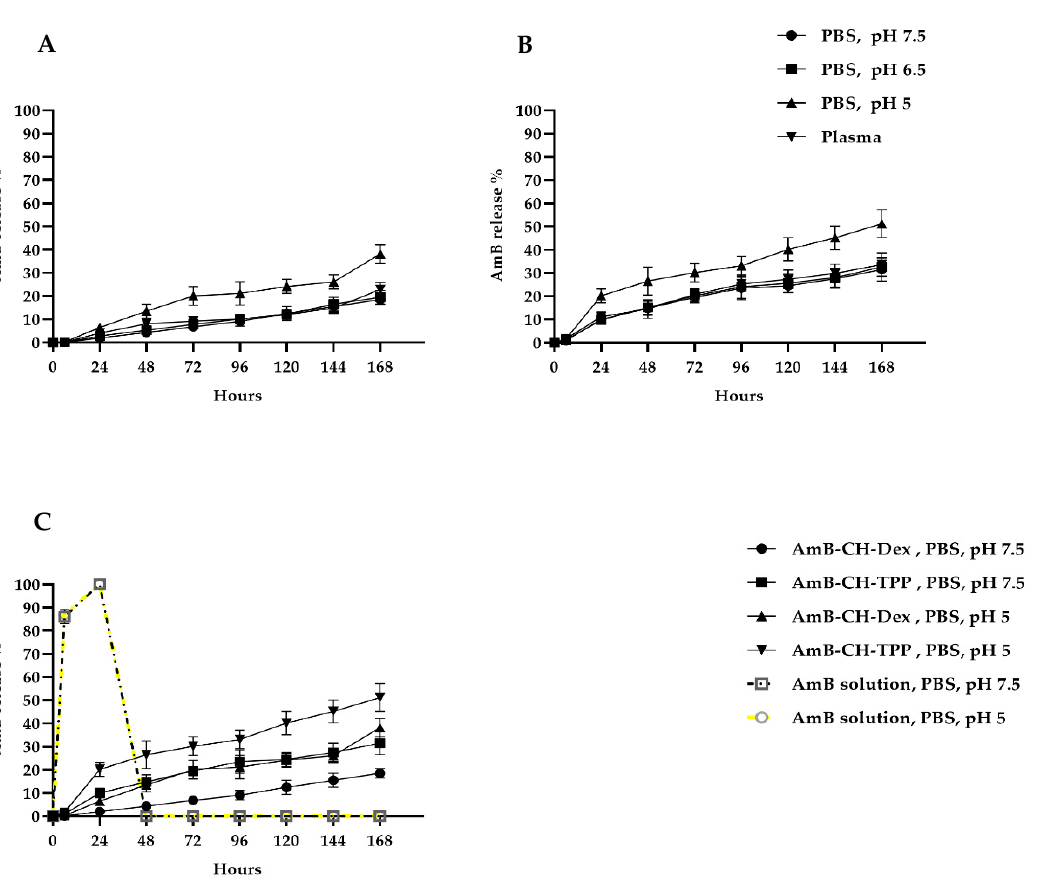
Figure 1. In vitro release profiles of AmB from chitosan nanoparticles at 37 ◦ C. ( A ) AmB-CH-Dex in PBS (pH of 5, 6.5 or 7.5) and mouse (BALB / c) plasma, ( B ) AmB-CH-TPP in PBS (pH of 5, 6.5 or 7.5) and mouse (BALB / c) plasma. ( C ) A comparison of AmB release from AmB solution, AmB-CH-TPP and AmB-CH-Dex nanoparticles in PBS at pH 5 and 7.5. Data expressed as mean +/ − SD (experiment was reproduced three times with confirmed similar data). AmB-CH-TPP size = 69 ± 8 nm and AmB-CH-Dex size = 174 ± 8 nm.